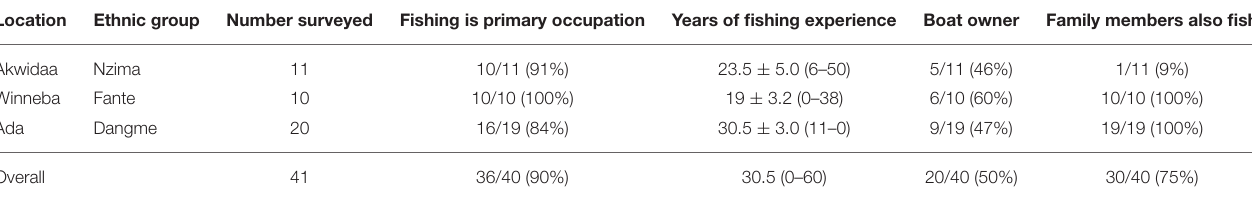
TABLE 1 | Demography of fishers selected for participation in the study. Location Ethnic